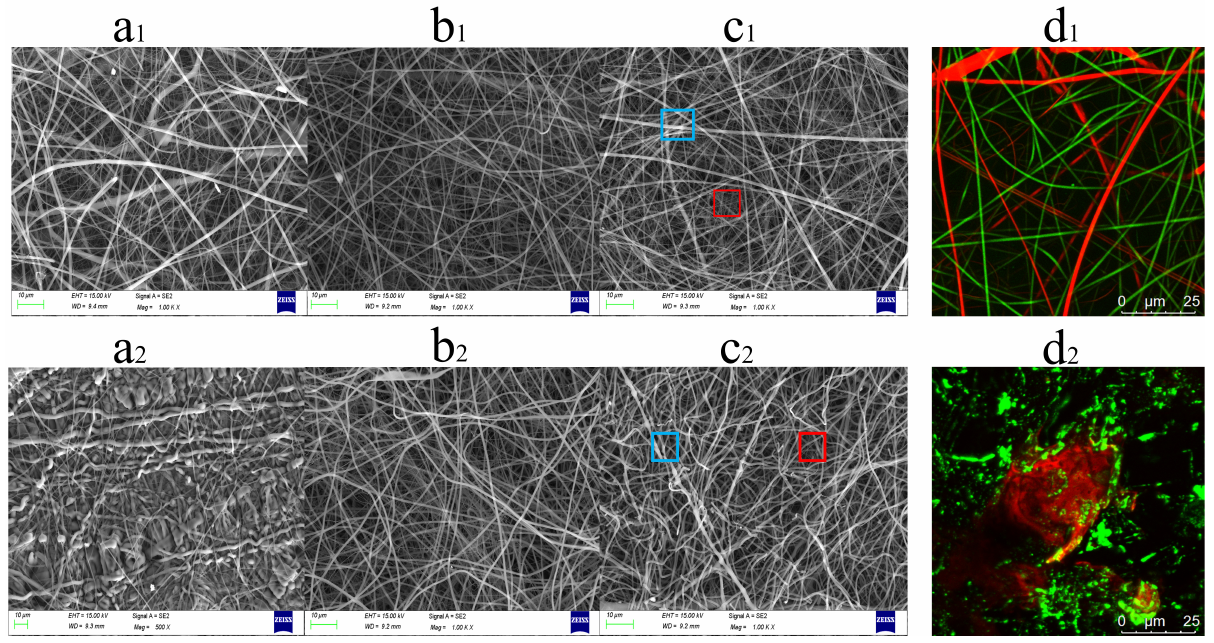
Figure 2. SEM images of PAA fiber membranes ( a 1 ), PVP fiber membranes ( b 1 ), PAA/PVP HFMs ( c 1 ), PAA gel fiber membranes ( a 2 ), PVP gel fiber membranes ( b 2 ), PAA/PVP HGFMs ( c 2 ), CLSM images of PAA/PVP HFMs ( d 1 ) and PAA/PVP HGFMs ( d 2 ). The blue box in c 1 and c 2 indicates PAA fibers and PAA gel fibers, respectively, and the red box in c 1 and c 2 indicates PVP fibers and PVP gel fibers, respectively. The membranes were prepared using a thermal crosslinking time of 45 min, and a UV-crosslinking time of 15 min. An electrospinning speed ratio of PAA/PVP of 5/8 was used to obtain the membranes shown in ( a – c